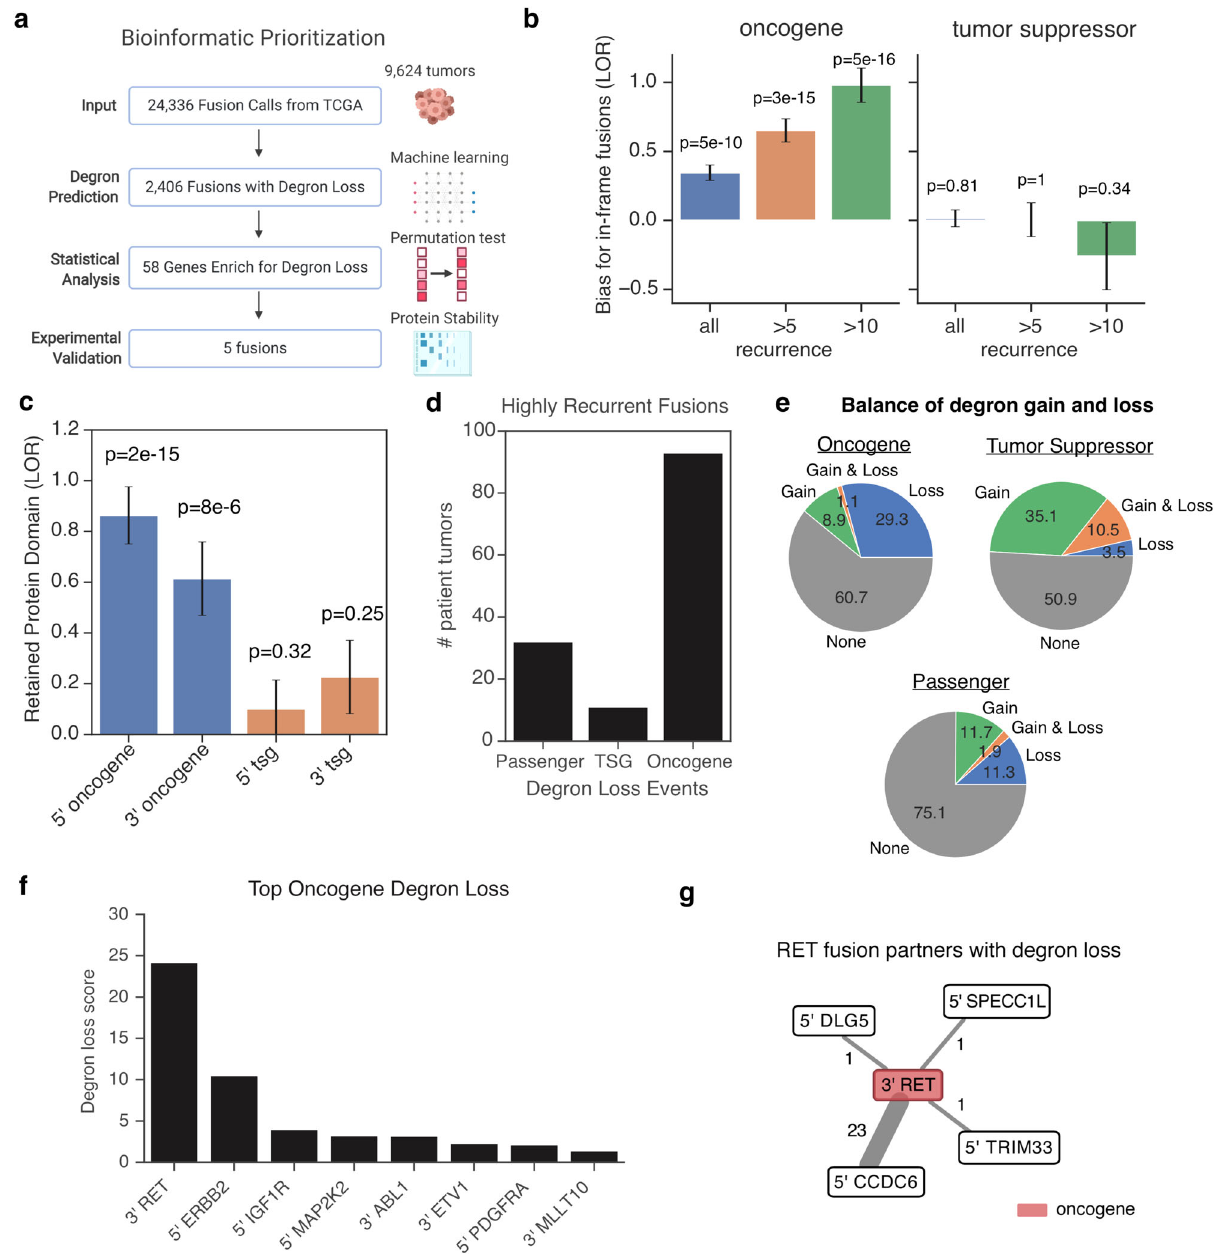
Fig. 2 Degron landscape of genetic fusions in cancer. a Combined analysis pipeline for validating cases of degron loss in fusion genes. Created with BioRender.com. b Enrichment for in-frame gene fusions for oncogenes and tumor suppressor genes relative to likely passenger genes (STAR methods). Recurrence is the number of tumors that a fusion gene was present in the TCGA. Barplot displays the log odds ratio (LOR), with error bars indicating ±1 SE. In order of bars from left to right, sample sizes (i.e. number of fusions) are n = 17,848, n = 4254, n = 1316, n = 17,581, n = 3,799, and n = 925. A two-sided Fisher ’ s exact test was performed. c Enrichment analysis for whether gene fusions result in the retention of at least one protein domain from the original protein sequence. Barplot displays the log odds ratio (LOR), with error bars indicating ±1 SE. In order of bars from left to right, sample sizes (i.e. number of fusions) are n = 8911, n = 9139, n = 8935, and n = 8896. A two-sided Fisher ’ s exact test was performed. d The total number of tumors in the TCGA that contain highly recurrent fusion genes (a fusion found in >10 tumors). e Balance of degron gain and loss in oncogene, tumor suppressor genes or passenger genes. f The top 10 most signi fi cant oncogenes that are biased towards loss of internal degrons in gene fusions. g Network diagram showing degron loss in the fusion partners to oncogene RET. Line width represents the frequency of the event. Red indicates previously annotated oncogenes. Numbers indicate the recurrence of the fusion across TCGA. The relevant raw data are provided in Source